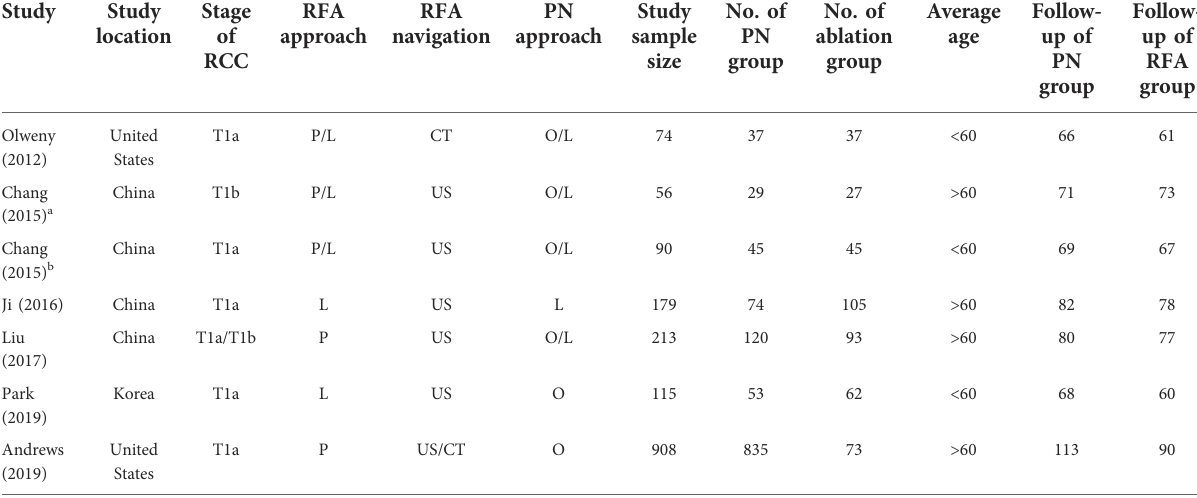
TABLE 1 Characteristics of included studies.